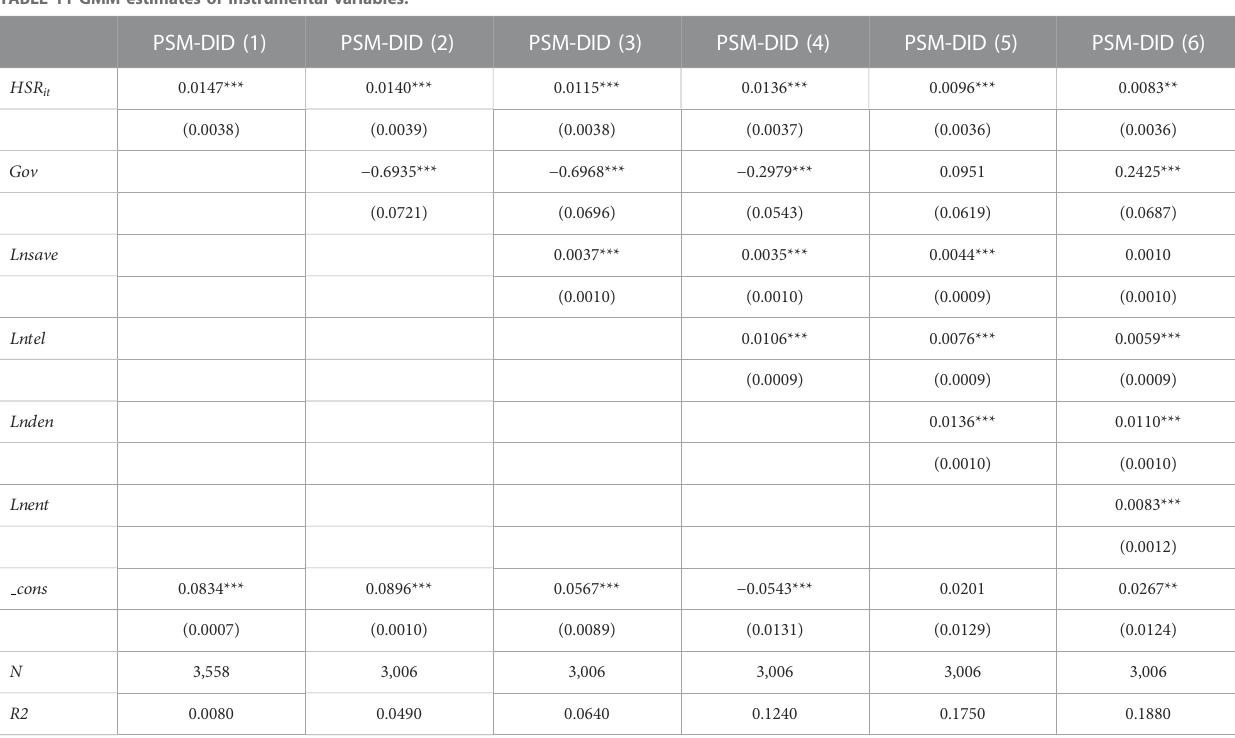
TABLE 11 GMM estimates of instrumental